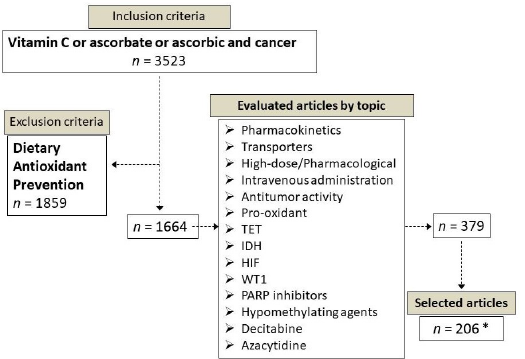
Figure 1. Flow chart of the inclusion and exclusion criteria applied for the selection of the articles cited in this review. * This number includes also articles providing background information that were retrieved by using specific PubMed